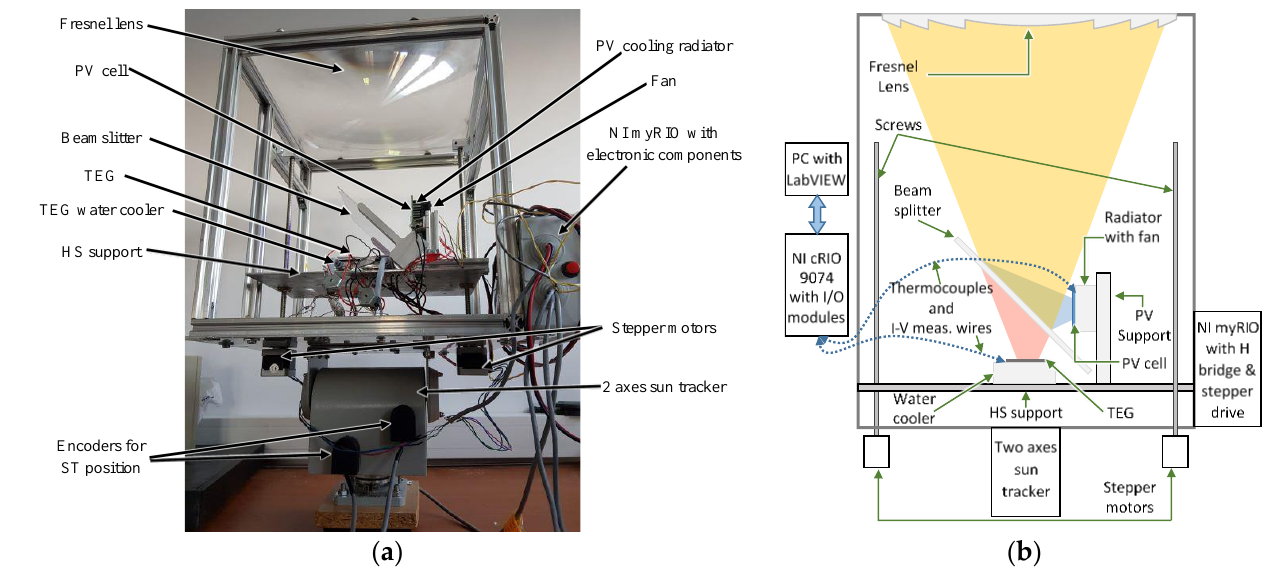
Figure 2. ( a ) The system setup; ( b ) schematic of the experimental setup.